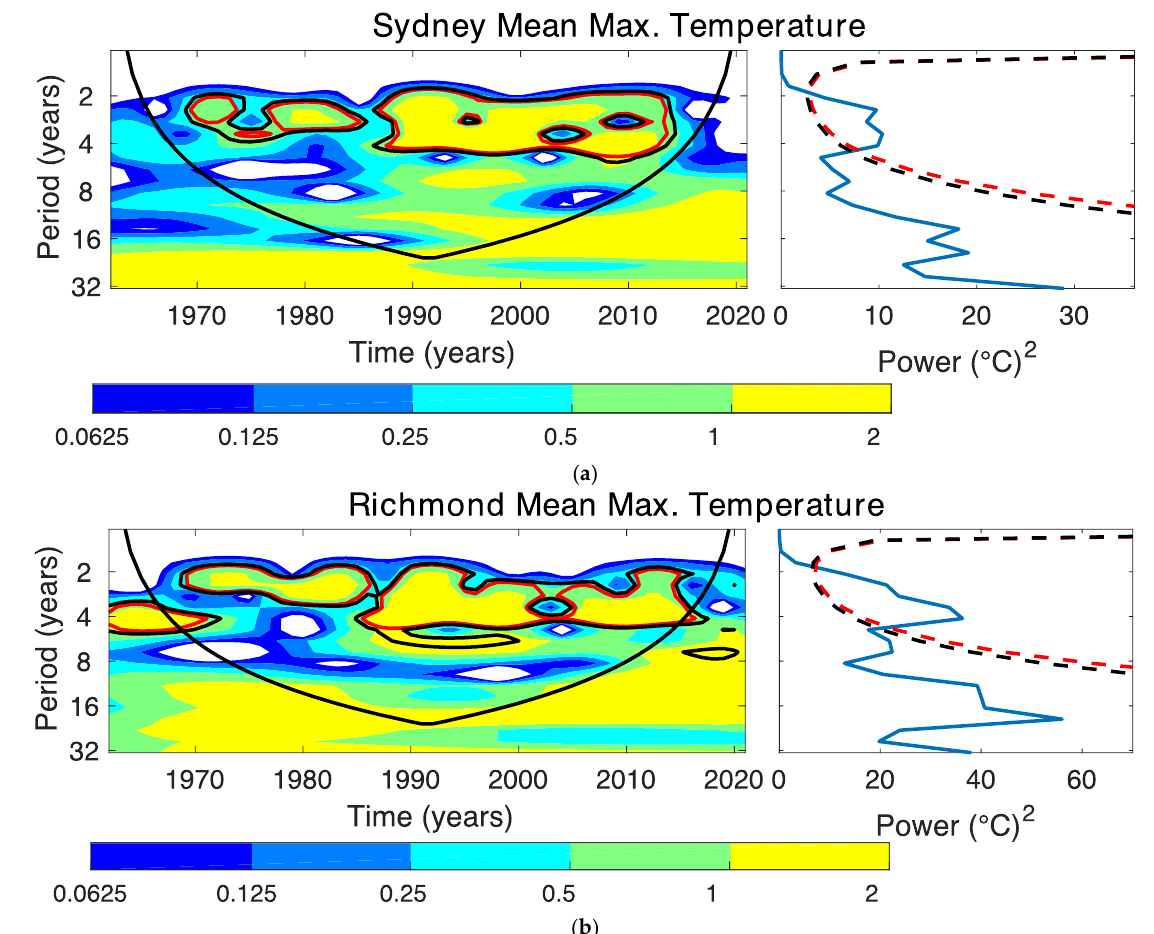
Figure 6. ( a ) Sydney time wavelet analysis for summer, mean maximum temperatures. The left panel shows the local wavelet power spectrum, and the right panel shows the global power spectrum, ( b ) Richmond time wavelet analysis for summer, mean maximum temperatures. The left panel shows the local wavelet power spectrum, and the right panel shows the global power spectrum.